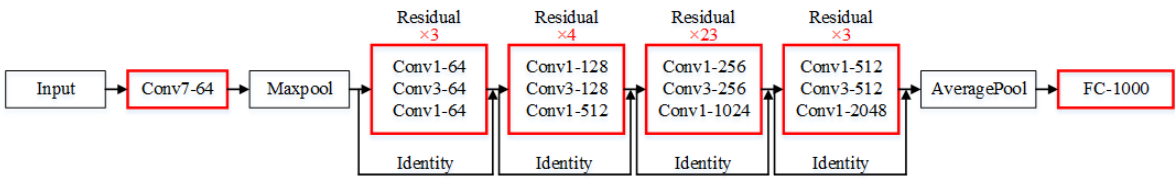
Figure 3. Defect detection flowchart of automotive engine parts.